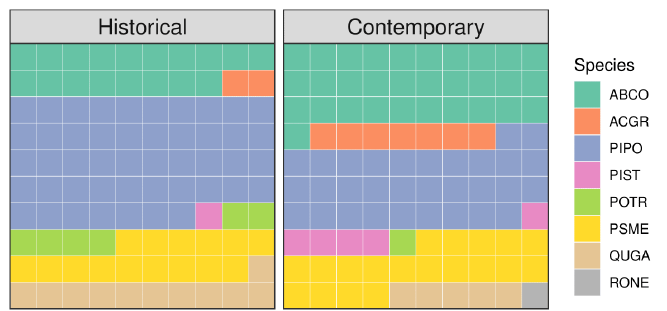
Figure 5. Historical and contemporary forest community composition. Squares are color coded by species, and each square represents 1 percent of total ecological importance values for the given time period across all plots combined. Species are identified by four letter codes: ABCO (white fir; Abies concolor ), ACGR (bigtooth maple; Acer grandidentatum ), PIPO (ponderosa pine; Pinus ponderosa ), PIST (southwestern white pine; Pinus strobiformis ), POTR (quaking aspen; Populus tremuloides ), PSME (Douglas-fir; Pseudotsuga menziesii ), QUGA (Gambel oak; Quercus gambelii ), and RONE (New Mexico locust; Robinia neomexicana). Comparison between the two panels shows a decrease in fire adapted species from 1879 to 2014.